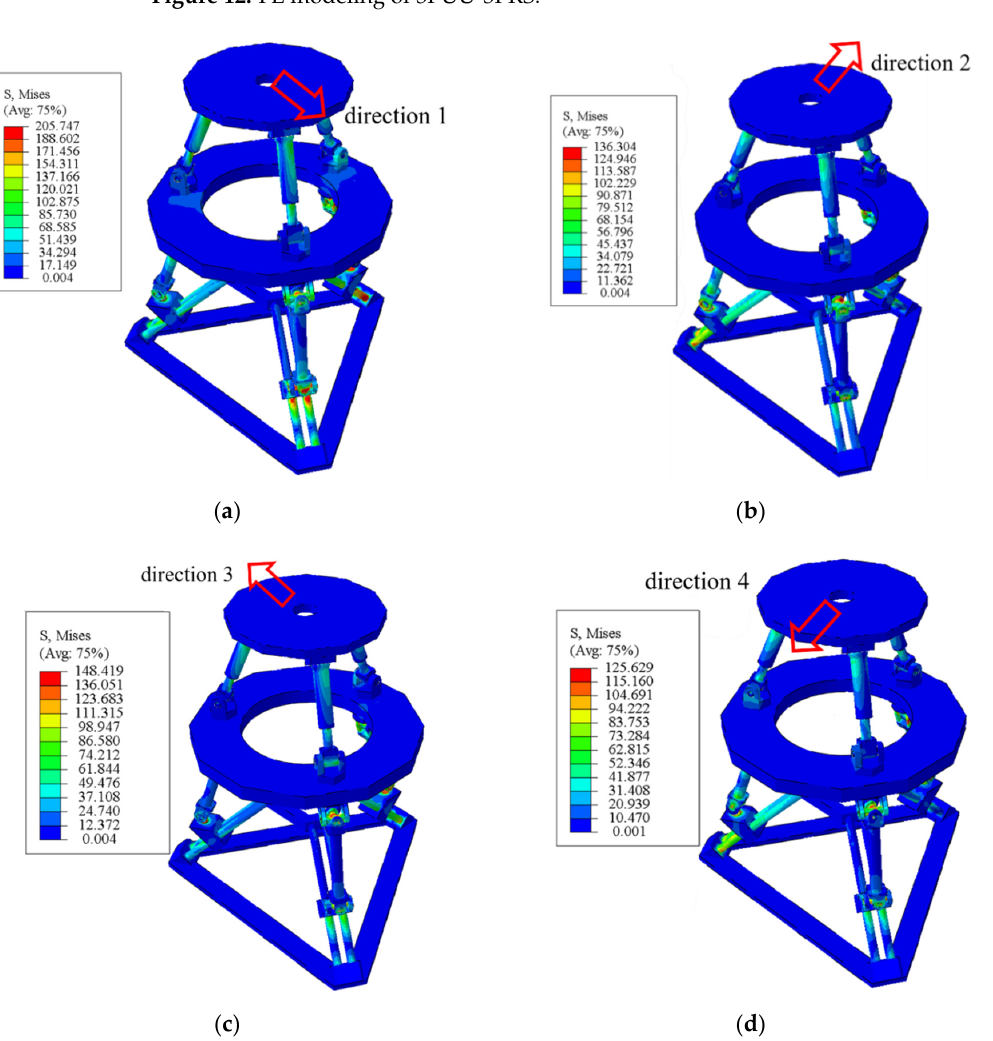
Figure 13. Stress distribution along different directions. ( a ) Stress distribution along the direction-1; ( b ) stress distribution along the direction-2; ( c ) stress distribution along the direction-3; ( d ) stress distribution along the